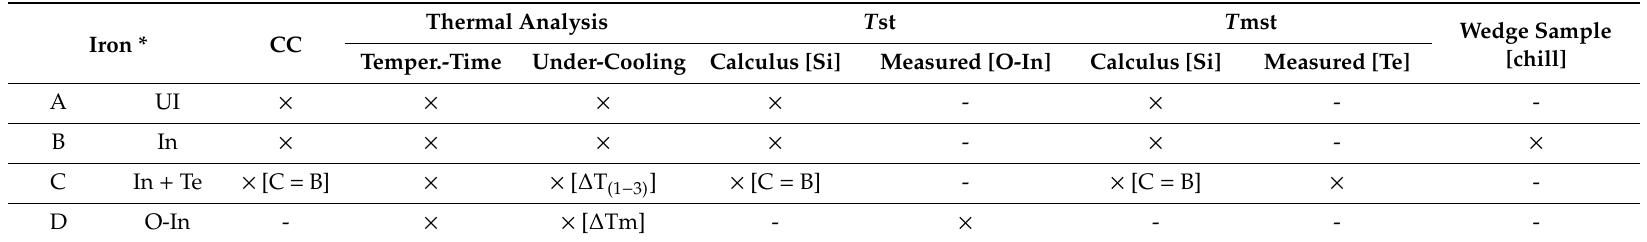
Table 1. Experimental procedure schedule of grey cast irons.